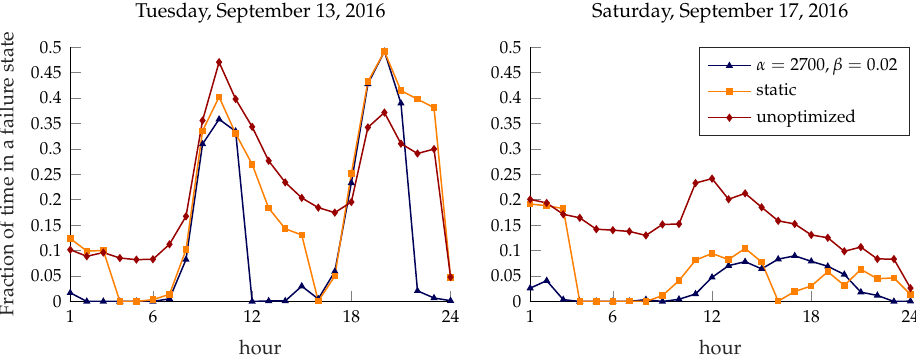
Figure 10. Average fraction of time in a failure state, plotted over the course of the